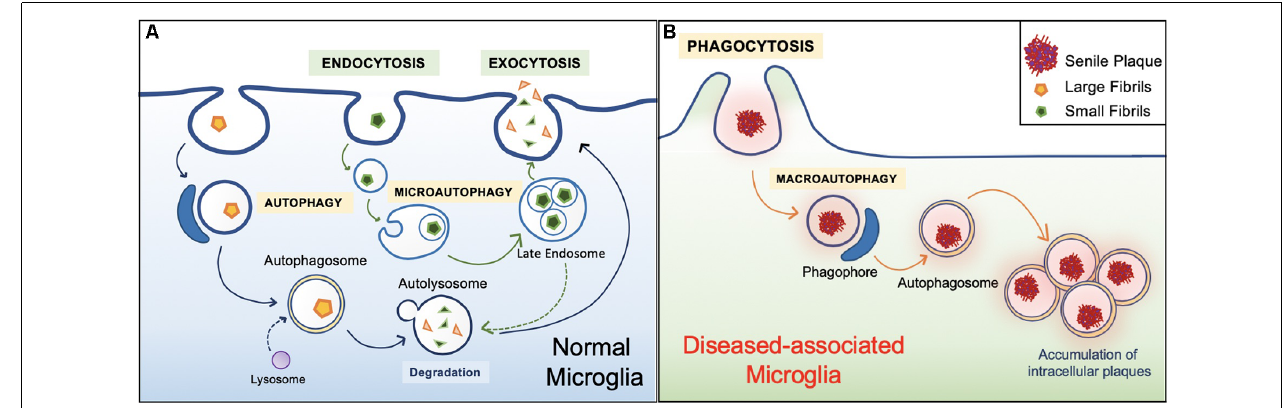
FIGURE 4 | Healthy vs. diseased A β clearance. (A) Homeostatic autophagy. In the healthy brain, endocytosis of A β oligomers and fibrils are normal (Lee and Landreth, 2010; Webers et al., 2020). Internalized A β substrates are sorted within the endocytic pathway. A β substrates are delivered to acidic lysosomes and late endosomes. Compartment acidification leads to degradation of A β oligomers and fibrils, then released via exocytosis (Sole-Domenech et al., 2016). (B) Diseased A β clearance. In the unhealthy brain, microglia engulf large A β plaques via phagocytosis. However, A β plaques are not properly degraded and instead harbored